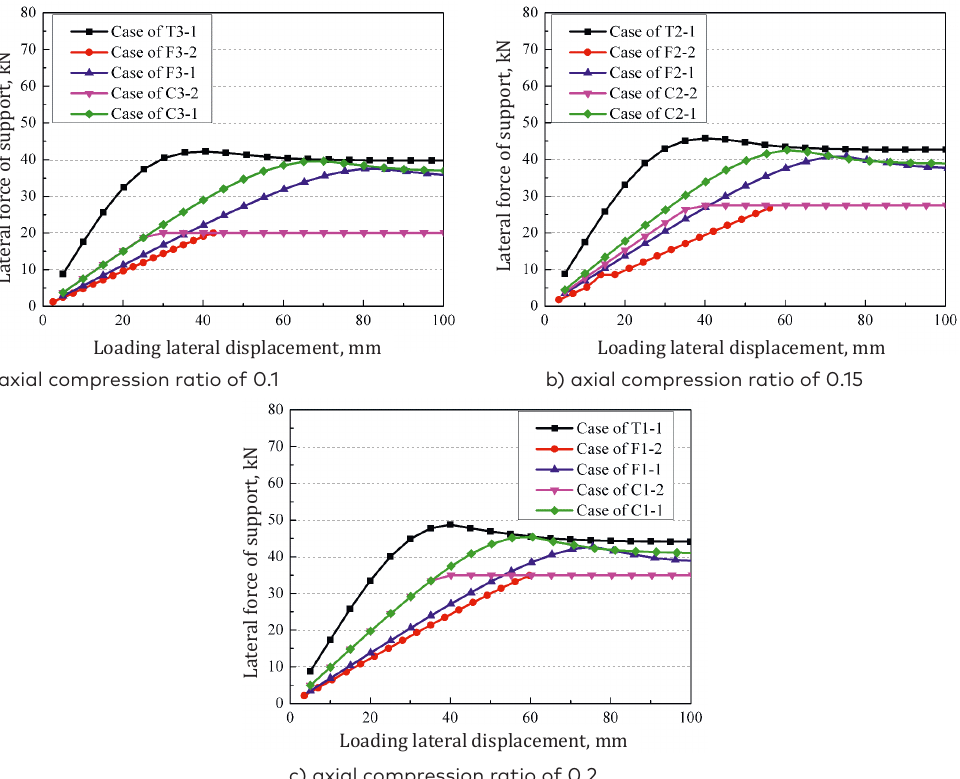
Figure 10. Comparison of the horizontal force of the bearing